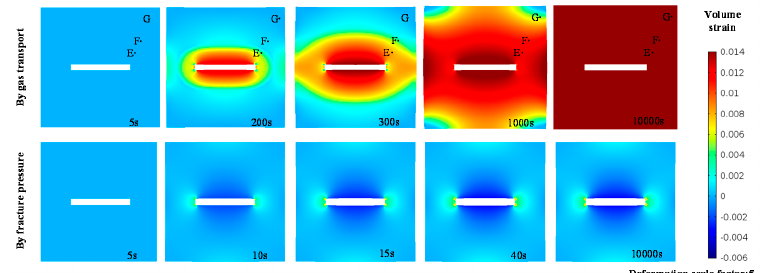
Figure 8. Matrix volume strain distribution at different times.